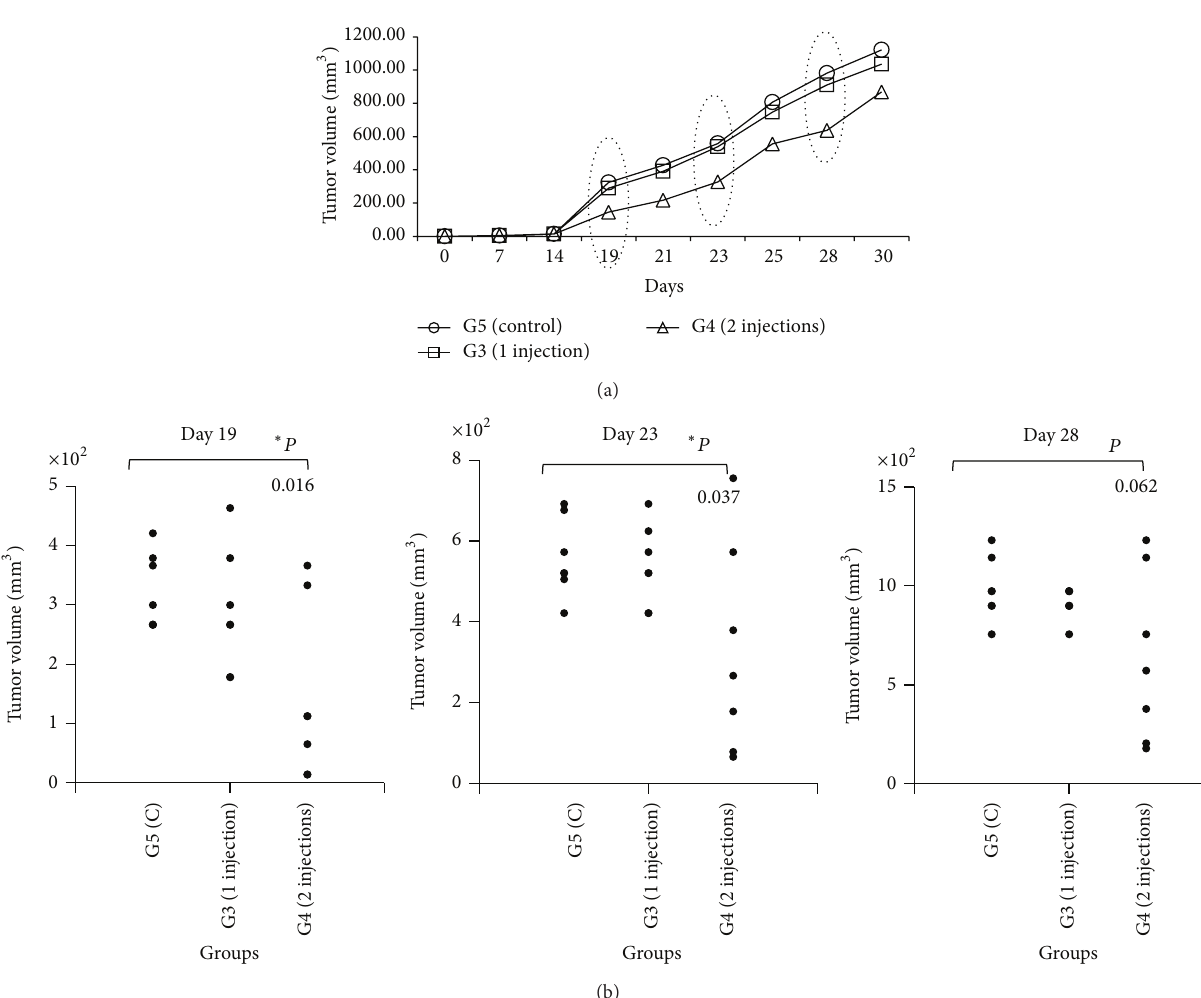
Figure 7: Primary tumor development in tumor-bearing mice inoculated intraperitoneally with htMSCs. (a) The average tumor volume of G3, G4, and G5 groups in each day is represented. (b) Tumor volumes of individual animals on days 19, 23, and 28. Animals injected with 2 doses of htMSCs showed significantly reduced tumor development compared to untreated control until 23 days after tumor inoculation.